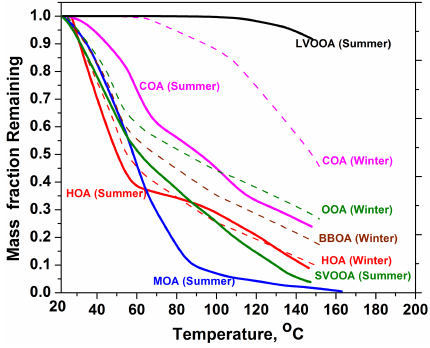
Figure 6. Estimated best-fit thermograms for all PMF factors. The solid lines represent the thermograms for the summer campaign and the dashed lines the thermograms for the winter campaign.